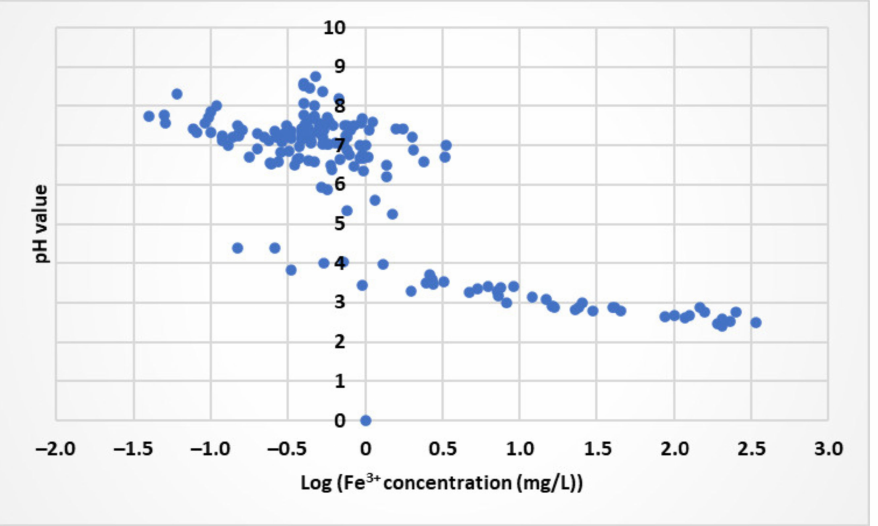
Figure 5. Plot of dependencies between Log (Fe 3+ ) and